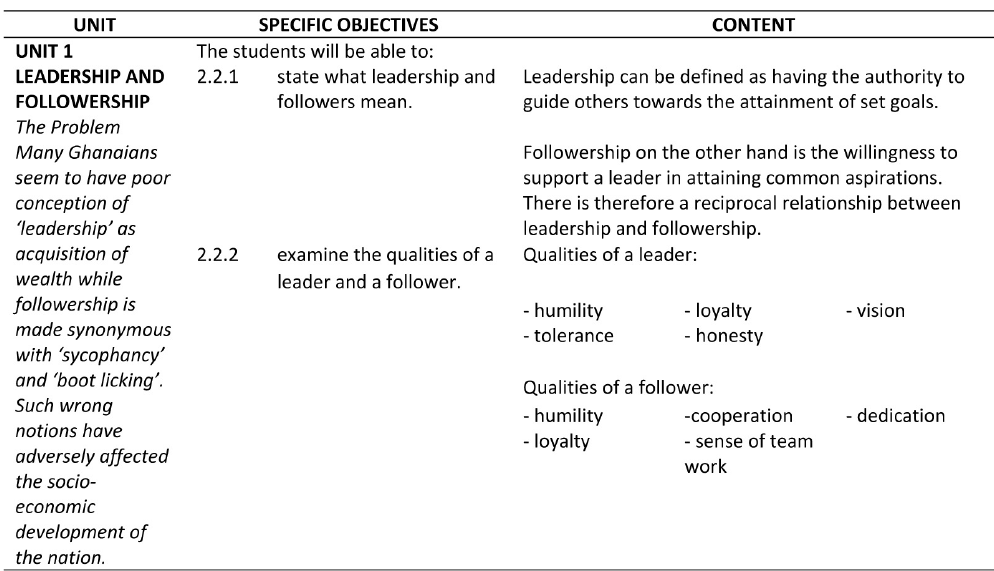
Figure 1: Qualities of leaders and followers in the senior high school social studies syllabus Source: CRDD,